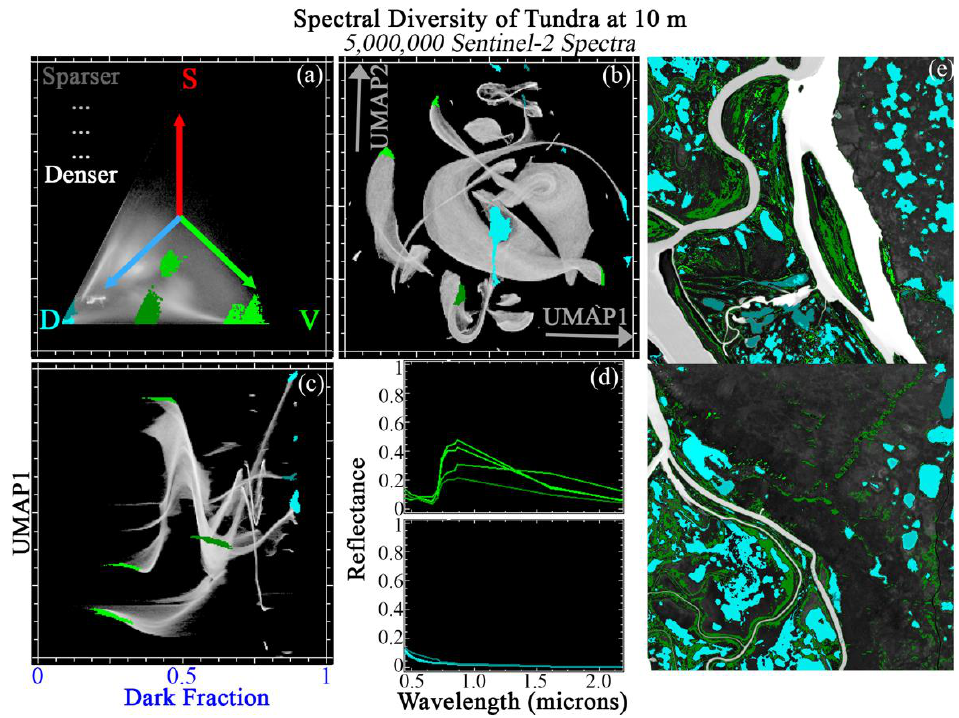
Figure 11. Joint characterization of tundra. 5 × 1 megapixel Sentinel-2 tile subsets are selected from global tundra diversity hotpots and analyzed at full 10 m pixel resolution. These spectra preferentially occupy the V to D apexes of the SVD mixing space ( a ), leaving the S portion of the space relatively sparse. The global 3-endmember linear mixture model fits these spectra better than the agricultural spectra (here, 99.8% of spectra with <5% RMSE). UMAP ( b ) captures both subtle mixing continua and discrete clusters, but does not offer physical interpretability. Joint characterization ( c ) uses the physical meaning of the Dark mixture fraction to contextualize the subtle statistical rela- tionships captured by UMAP. Example regions of interest are identified from the joint space and projected onto the ternary mixing and UMAP spaces. Mean spectra for each region ( d ) illustrate similarities and differences among statistically distinct clusters. Clusters identified by joint charac- terization also frequently show geographic coherence ( e ). 3.8. Mangroves and Wetlands Figure 12 shows JC applied to a compilation of 10 tiles from diverse mangrove and wetland landscapes. Mixture fractions from these landscapes are distributed similarly to tundra, preferentially occurring near the D V mixing line, with minor additional mixing towards S (consistent with more open canopies resulting in subpixel mixing with water or dark, water-saturated soils) (top left). Like the forest, senescent vegetation, and tundra